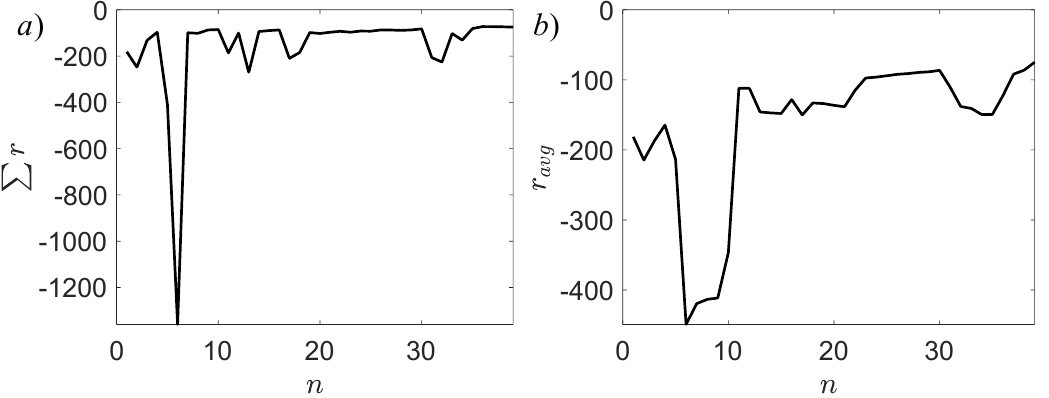
Figure 11. Learning curve of agent A on Case 11 featuring dry friction. ( a ) Cumulative reward per episode of training. ( b ) Average reward per episode of training in a five episode